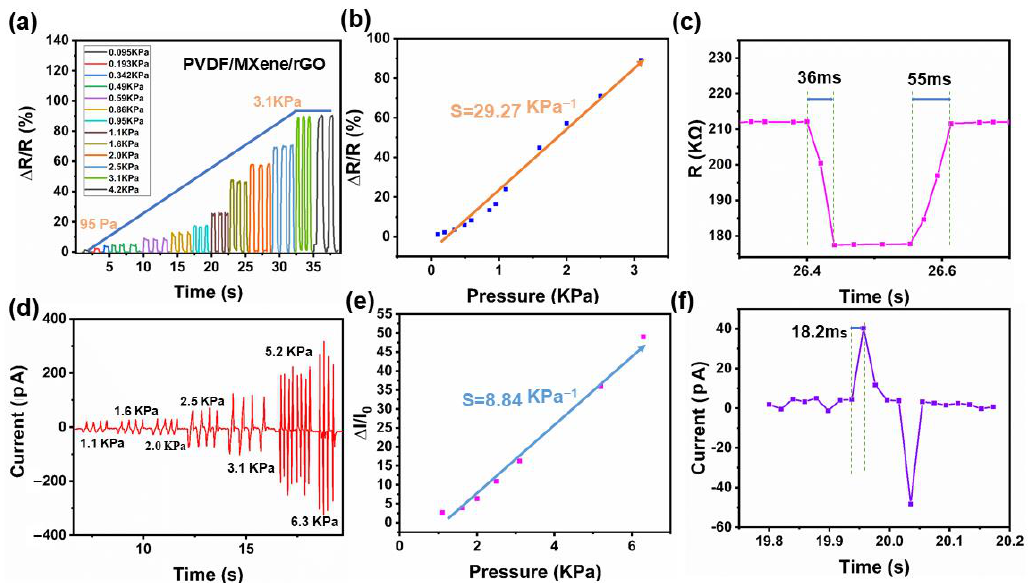
Figure 8. ( a ) Sensing range of the piezoresistive properties of the PMR dual-mode flexible sensor. ( b ) Sensitivity of the piezoresistive mode. ( c ) Response/recovery time of the piezoresistive mode. ( d ) Sensing range of the piezoelectric mode. ( e ) Sensitivity of the piezoelectric mode. ( f ) Response time of the piezoelectric mode.